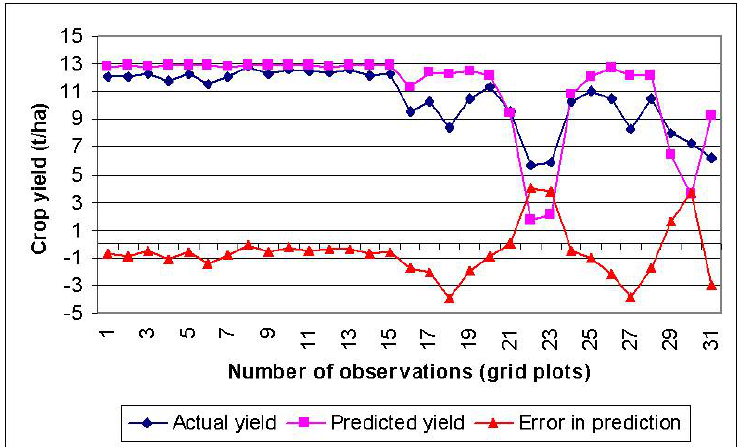
Figure 13. Comparison of actual versus predicted corn yield using testing dataset of the optimal prediction model of the year 1998 (Transformed PVI 98).